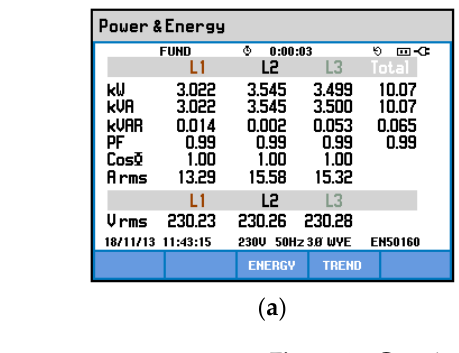
Figure 46. Case 6—four-wire ShAPF operating with unbalanced loads: ( a ) source power; ( b ) voltage and current waveforms in phase S .